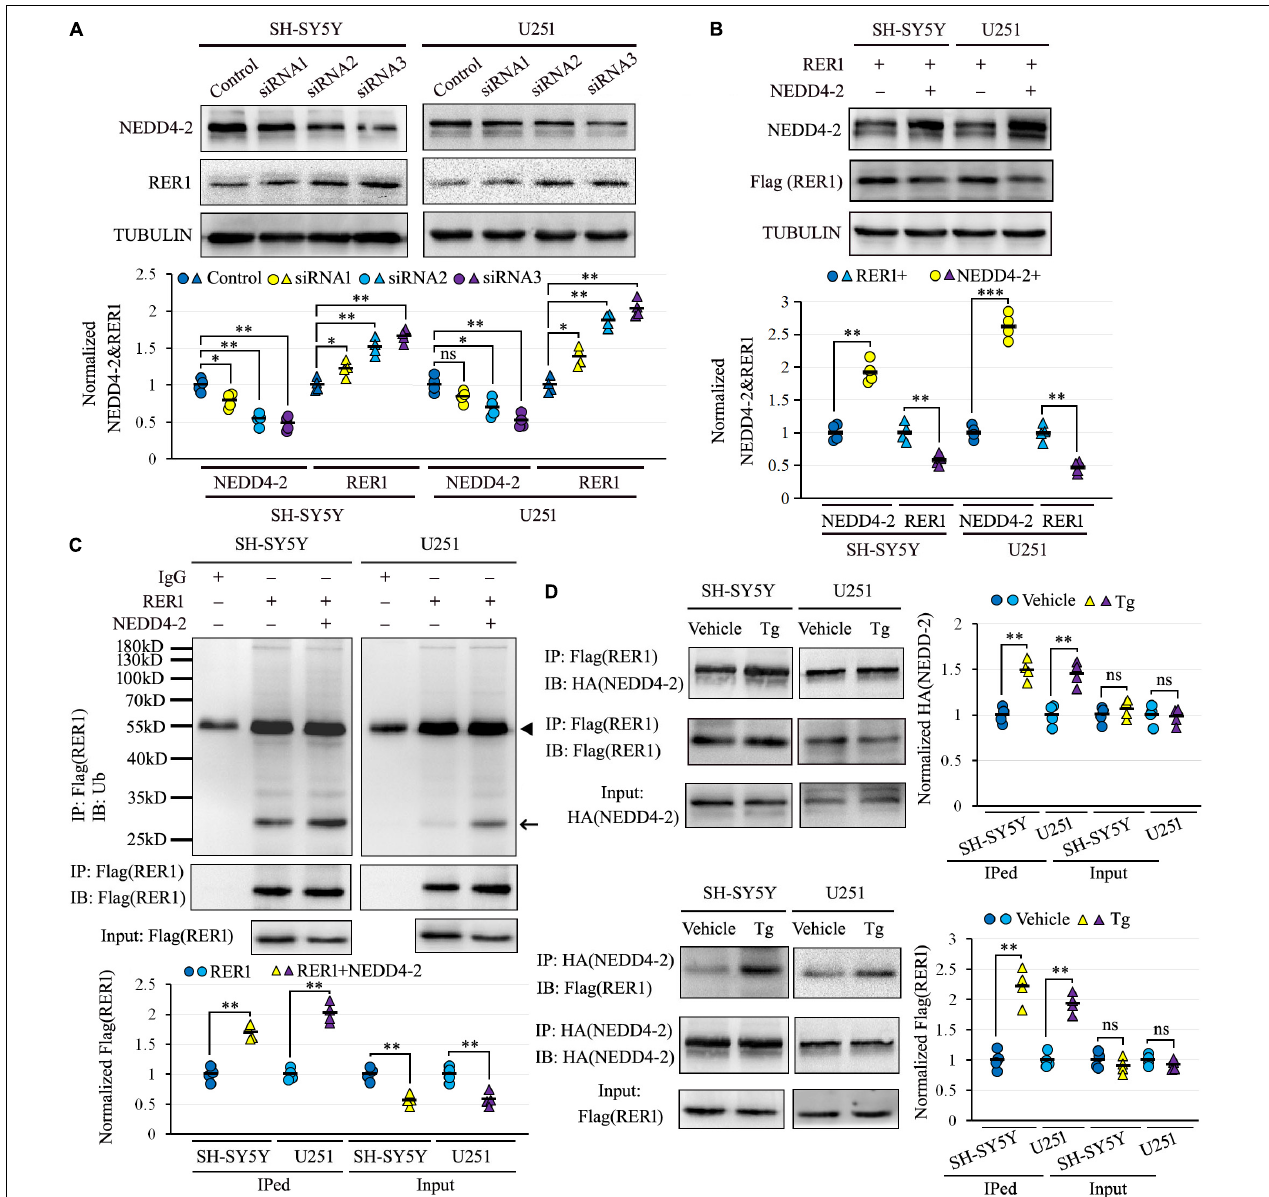
FIGURE 3 | NEDD4-2 ubiquitinated RER1, especially under ER stress in vitro . (A) Western blotting of RER1 and NEDD4-2 in SH-SY5Y and U251 cells treated with NEDD4-2 siRNAs ( n = 4 independent cell preparations). ns, not significant, ∗ P < 0.05, ∗∗ P < 0.01 compared with the control cells by post hoc Tukey’s analysis. (B) Western blotting of RER1 and NEDD4-2 in SH-SY5Y and U251 cells co-transfected with RER1-Flag and NEDD4-2-HA or vacant vectors ( n = 4 independent cell preparations). ∗∗ P < 0.01, ∗∗∗ P < 0.001 compared with the control cells by Student’s t -test. (C) Ubiquitination of RER1 in the co-transfected cells immunoprecipitated with Flag antibodies and immunoblotted with ubiquitin antibodies ( n = 4 independent cell preparations). The ubiquitinated Flag-tagged RER1 is indicated by an arrow. The heavy chain of IgG is indicated by a triangle. ∗∗ P < 0.01 compared with the control cells by Student’s t -test. (D) Co-immunoprecipitation analysis for the interaction of NEDD4-2 and RER1 using anti-Flag and anti-HA antibodies in the transfected cells with or without Tg (0.5 µ M) treatment ( n = 4 independent cell preparations). ns, not significant, ∗∗ P < 0.01 compared with vehicle group by Student’s t